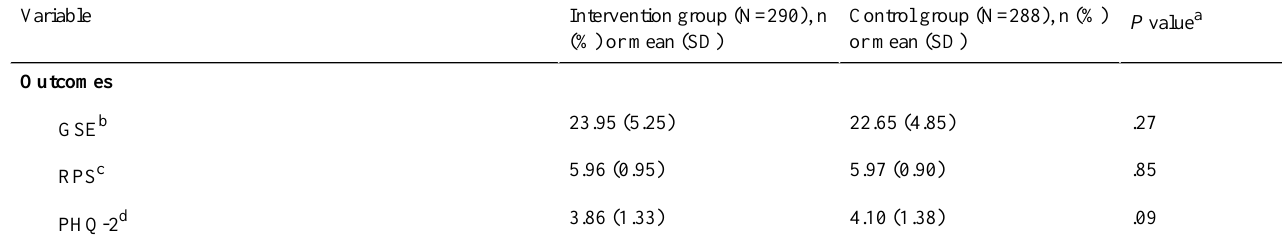
a Chi-square test is used to compare the statistical difference in categorical variables between groups. Mann-Whitney U test is also used. b GSE: general self-efficacy scale.